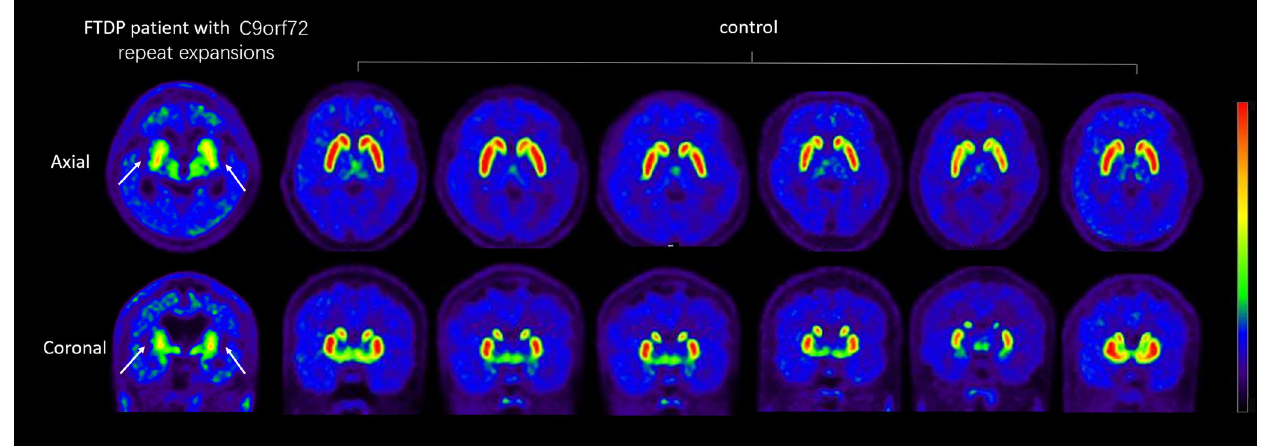
Fig. 3 Reduced dopamine terminal in FTPD patients with C9orf72 expansion. DTBZ-PET/CT imaging of the VMAT2 distribution in the FTDP patient (III-6) with C9orf72 expansion and controls ( n = 6). The same slice is presented for all participants. White arrows indicate obvious dopamine decline of the bilateral striatum in the patient. Note the symmetric decline of vesicular transporter availability without a posterior- to anterior